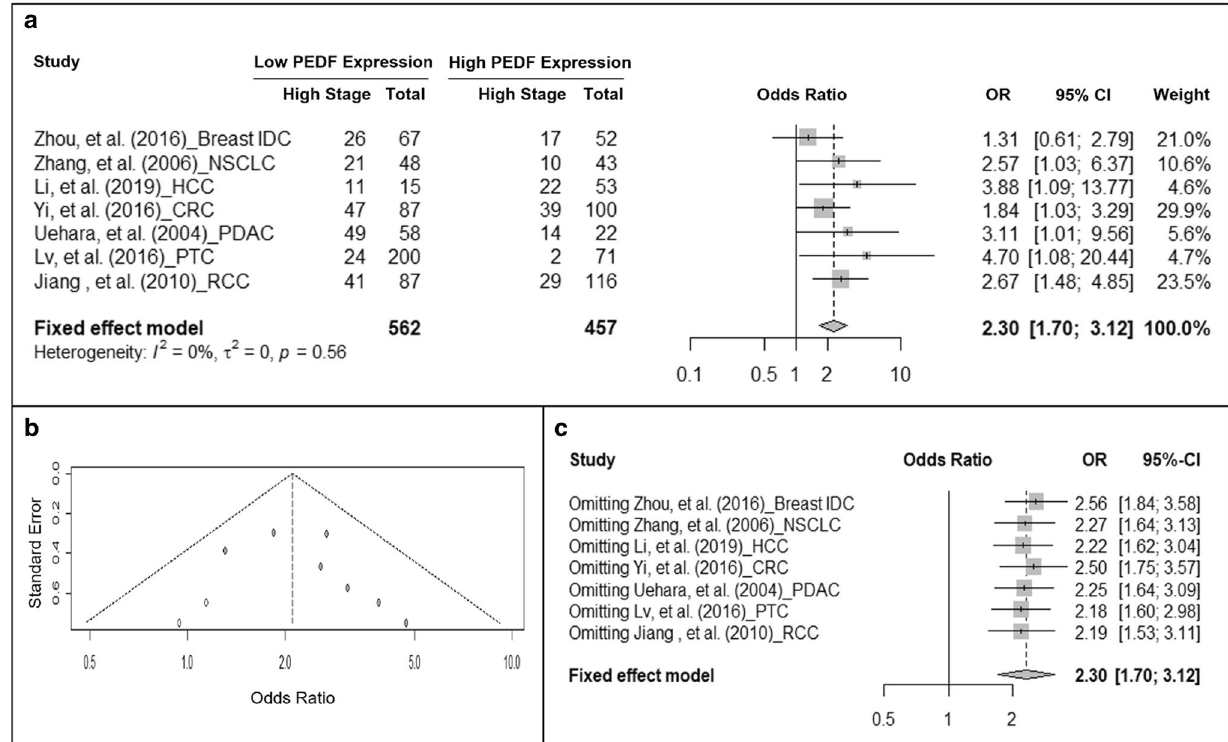
Fig. 2 Cancer with low PEDF expression has higher odds to have higher TNM staging. a Forest plot showing the association of PEDF expres- sion and cancer TNM staging. Squares indicate study-specific odds ratios (ORs). The size of the box is proportional to the weight of the study. Horizontal lines indicate 95% confidence intervals (CI). A diamond indicates the summary OR with its corresponding 95% CI. b Funnel plot on the publication bias of studies on PEDF expression and TNM staging. Each filled circle represents one study. Open circles repre- sent added artificial studies to correct publication bias. c Forest plot of sensitivity test. Squares indicate the summary OR after omitting one specific study. Horizontal lines indicate 95% CI. A diamond indicates the summary OR of all the studies with its corresponding 95% CI.